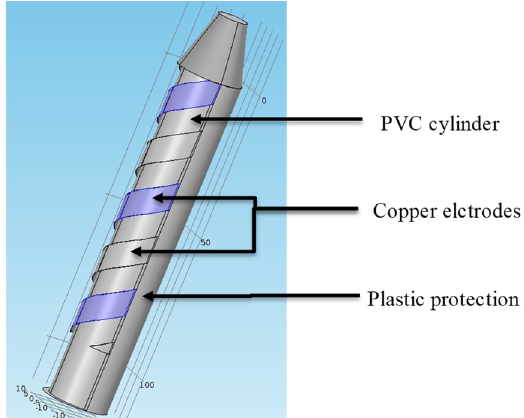
Figure 10. Helicoidal sensor shape.